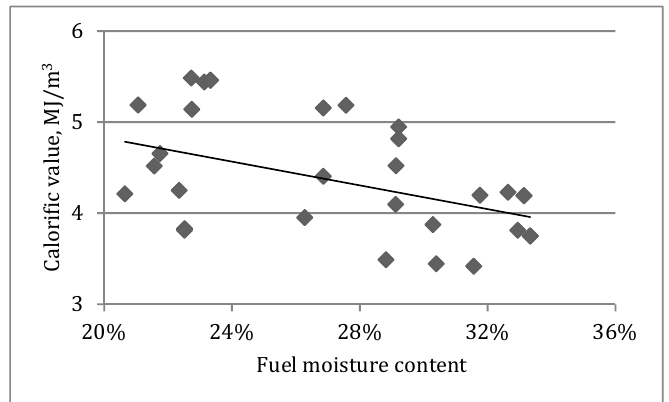
Figure 6. Syngas caloric value vs. fuel moisture content .